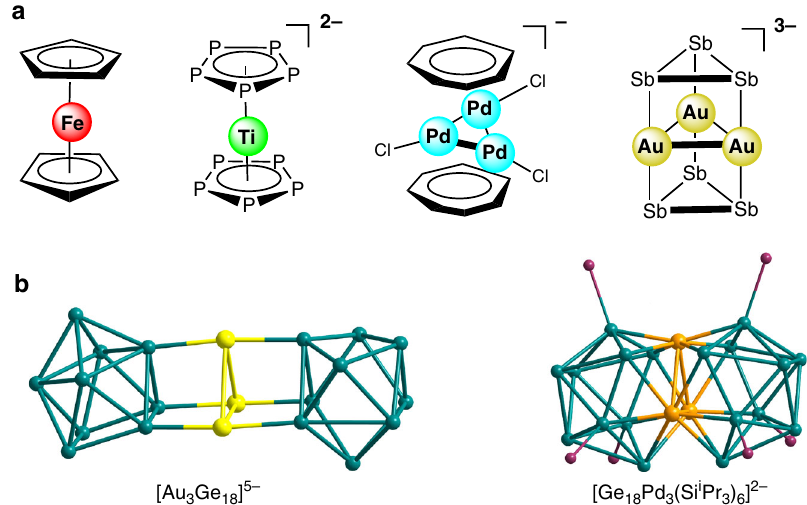
Fig. 1 Schematic representations and structures of selected examples of known sandwich complexes. a Schematic representations of selected sandwich complexes. b Structures of analogous Ge-containing sandwich complexes. (Ge-atoms are green, Au-atoms are yellow, Pd-atoms are orange, and Si-atoms are